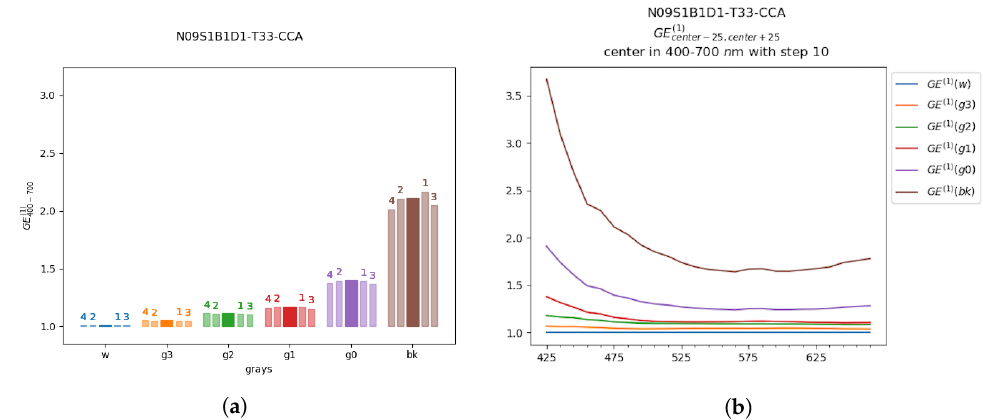
Figure 9. Example of GE ( 1 ) plot representation of the CCA on image N09S1B1D1-T33 . Plot ( a ) represents average values of glare effect of each grayscale patch in a range from 400nm to 700nm. The central solid color bar represents the GE values obtained from the central region of the grayscale patch; the labels 1, 2, 3, 4 refers to the GE values obtained from data of the regions toward the patch corners (see patch regions in Figure 4). In ( b ) the average values of GE ( 1 ) are represented for each wavelength from 400nm to 700nm and smoothed by applying a sliding window in the considered